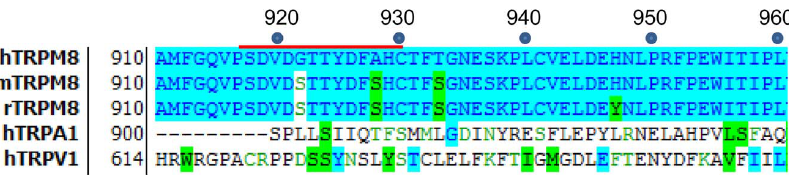
Figure 1. Alignment of extracellular pore loop sequences. Alignment of the third extracellular loop sequences of the human, rat and mouse TRPM8 channel and the human TRPA1 and TRPV1 channels. The red line indicates the epitope sequence that ACC-049 was generated